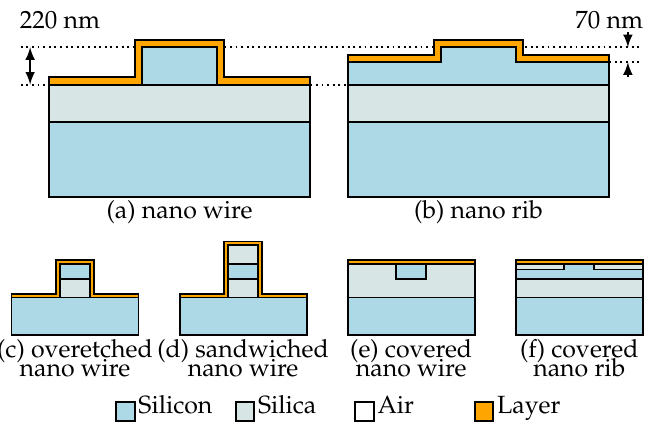
Figure 2. Sketches of the applied ( a , b ) and proposed ( c – f ) waveguide